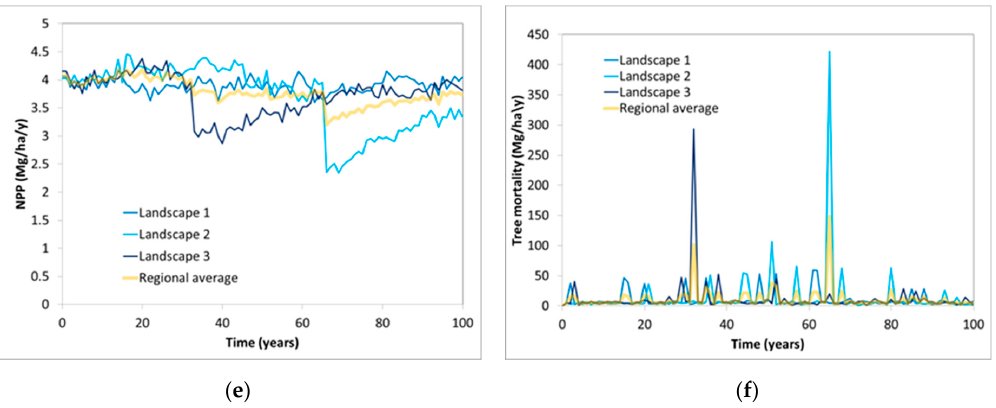
Figure 3. Hypothetical temporal variation in NPP (net primary productivity) versus mortality at three different levels of forest ecosystems: trees, stands, and landscapes: ( a ) NPP at level of individual trees, ( b ) mortality at level of individual trees, ( c ) NPP at level of stands, ( d ) mortality at level of stands, ( e ) NPP at level of landscapes and region, and ( f ) mortality at level of landscapes and region.